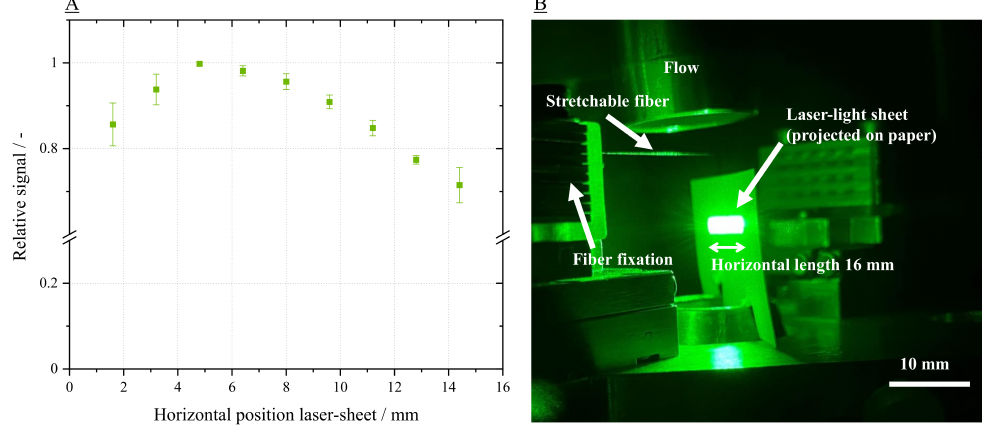
Figure 6. ( A ): Relative signal of beam intensity profile, measured in horizontal direction of laser sheet (below the fiber), total horizontal length of laser sheet 16mm. ( B ): Image of laser sheet in the measurement chamber. Here the laser light sheet is projected onto a piece of paper below the stretchable fiber. Distorted view due to viewing